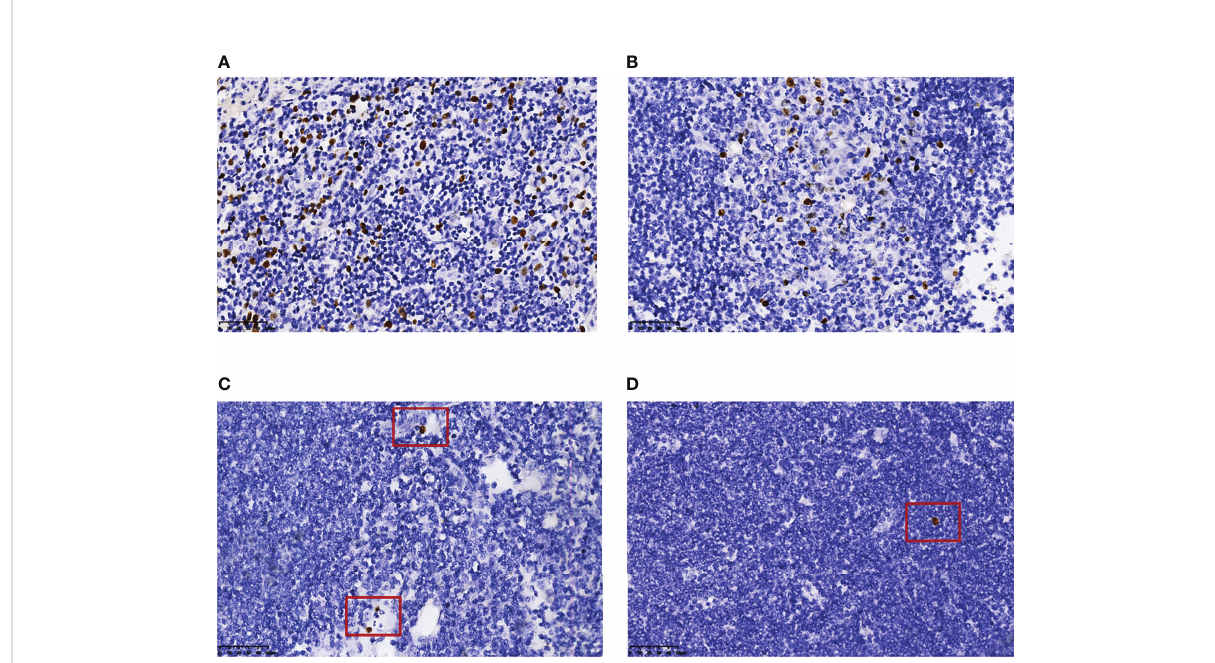
FIGURE 3 Number and distribution of EBER-positive cells. More than 100 EBER-positive cells, most of which accumulated near tumor cells (A) (case 1). EBER-positive cells, in the range of 10 – 100, distributed in the inter-tumor area (B) (case 4). EBER-positive cells, in the range of 1 – 10, scattered beside tumor cells (C) (case 5). One EBER-positive cell was scattered beside the tumor cells (D) (case 6). All images were captured at ×400 magni fi